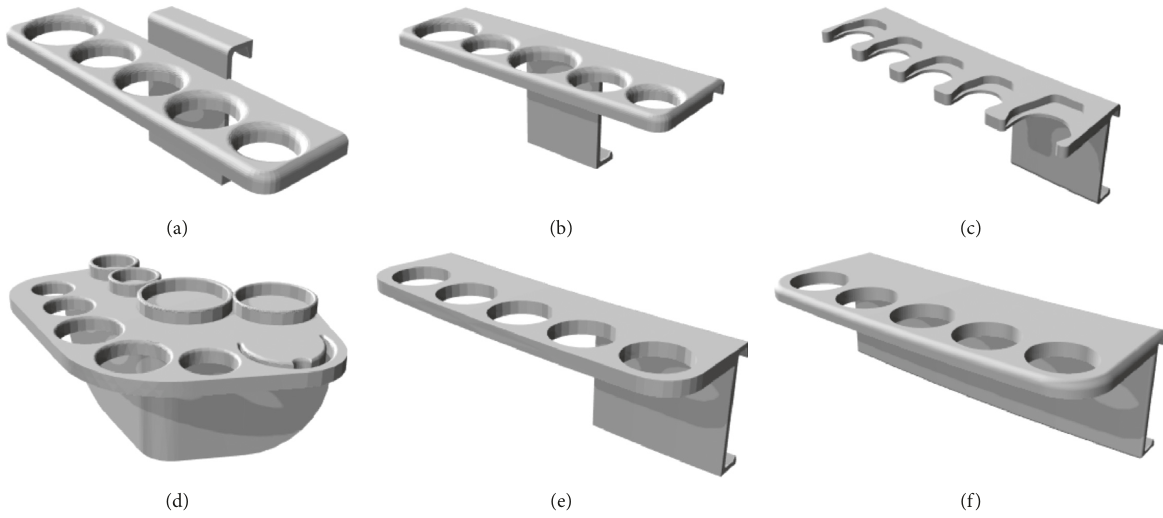
Figure 2: Serial syringe bracket designs based on iterative prototyping and user feedback: (a) initial prototype, (b) elevation of main surface to provide further clearance from anesthesia machine display, (c) alternative slot configuration using flange to hold syringe and allow front- loading and unloading, (d) corner-mounted design including holders for unopened medication vials and a bougie, (e) anterior extension of main surface to provide further clearance from machines with mounted depth of anesthesia monitors, (f) final design with wider support clip for increased stability. A detailed review of the rationale and utility of each of these design features is provided in Supplementary Table